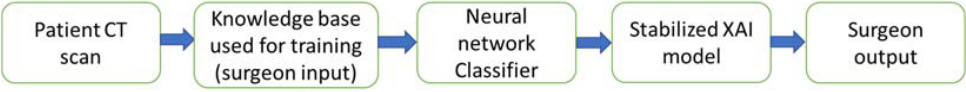
Figure 1. Overall processing steps of the intelligent thoracic diagnosis assistance system